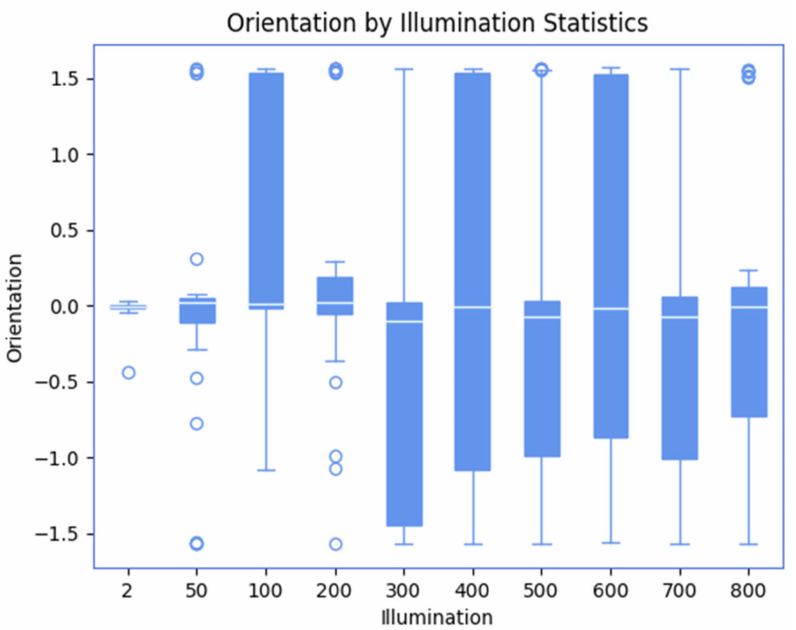
Figure 9. Orientation distribution diagram at different light levels; circles—outliers (values whose absolute values exceed 1.5 ·